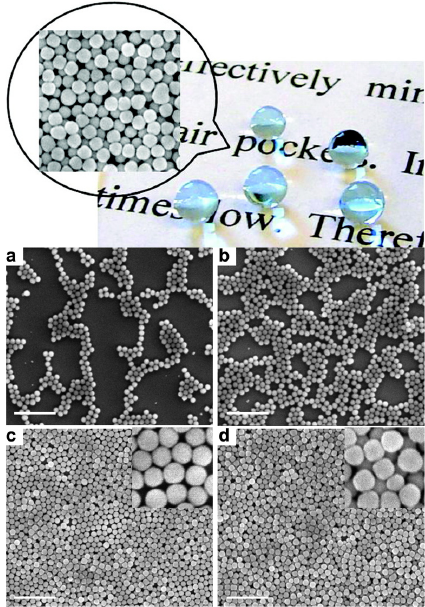
Figure 4. Top Panel: Photograph of the transparent F ‐ SiO 2 NP (fluorinated silica nanoparticle film) on a glass slide. SEM images of spin ‐ coated 100 nm F ‐ SiO 2 NPs with different concentrations on TESPSA ‐ functionalized Si wafers: ( a ) 0.1, ( b ) 0.4, ( c ) 0.8, and ( d ) 1.2 wt.%. The insets in c and d are high ‐ magnification images. Scale bars: 1 μ m [29].